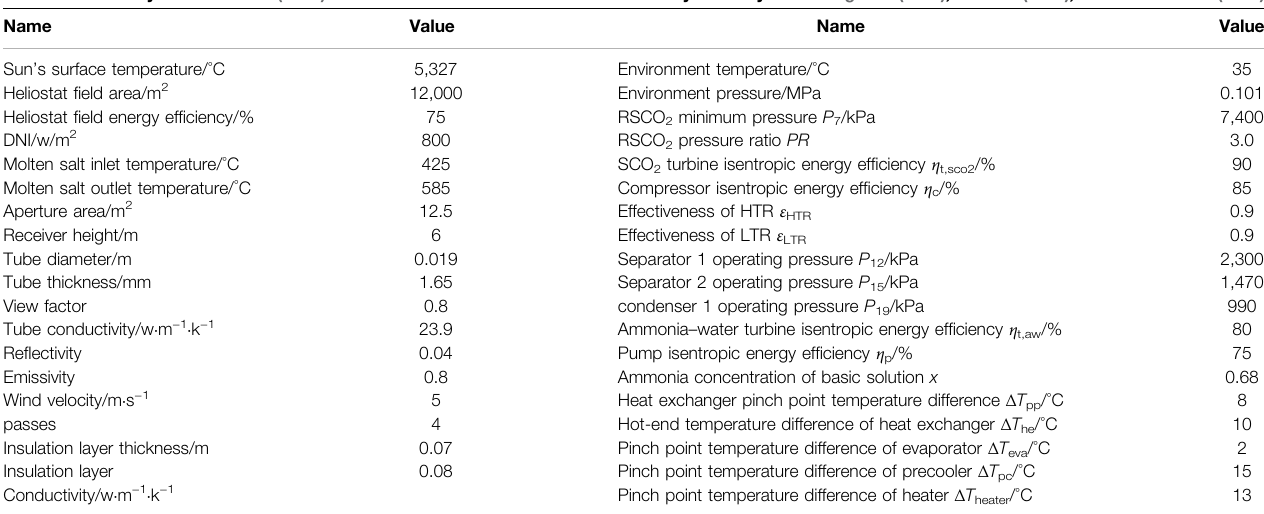
TABLE 3 | System baseline simulation condition. Tower solar subsystem Xu et al. (2011)